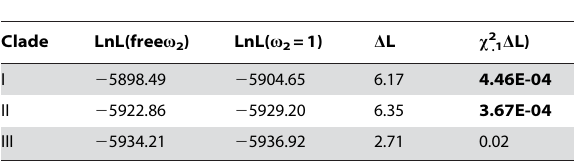
Table 4. Test of positive selection of the rrgB gene.